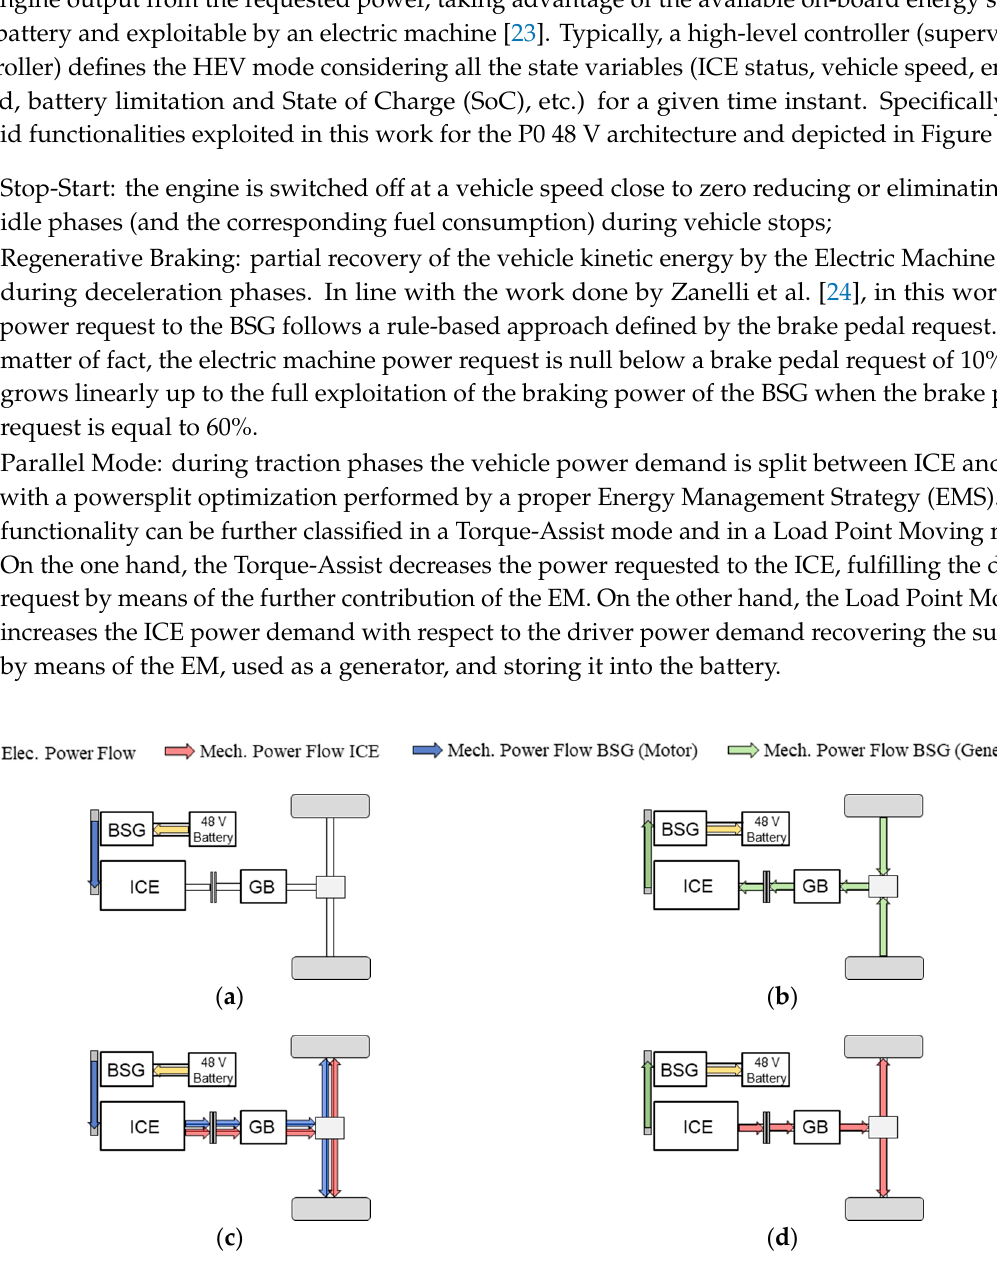
Figure 1. Schematic representation of the main Hybrid Electric Vehicle (HEV) modes for a P0 48 V architecture: ( a ) Stop-Start; ( b ) Regenerative Braking; ( c ) Torque-Assist; ( d ) Load Point Moving.